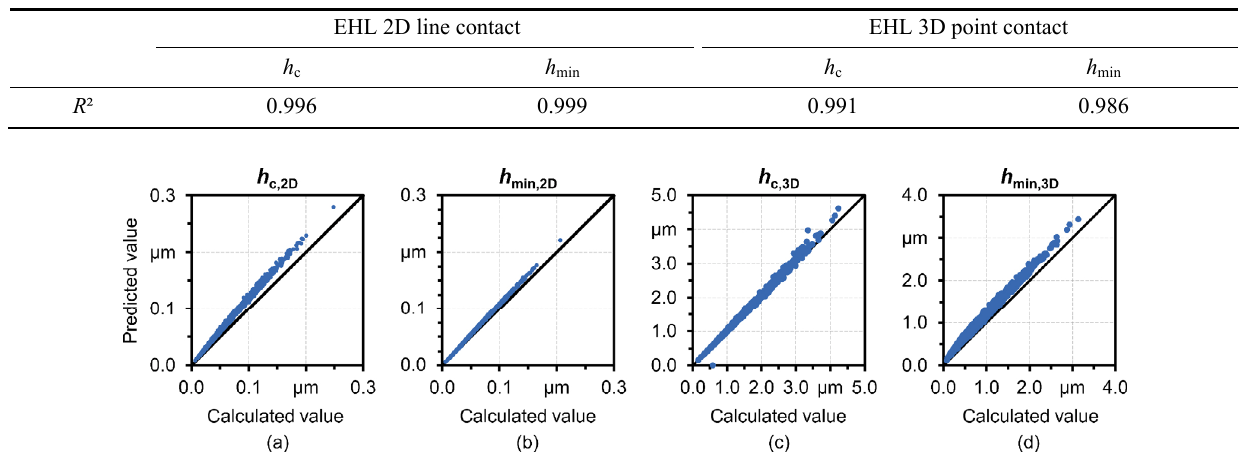
Fig. 6 Central and minimum film thickness predicted from the proximity equations (vertical axis) versus the calculated ones from EHL simulations (horizontal axis) for the (a, b) infinite 2D line and (c, d) 3D circular point